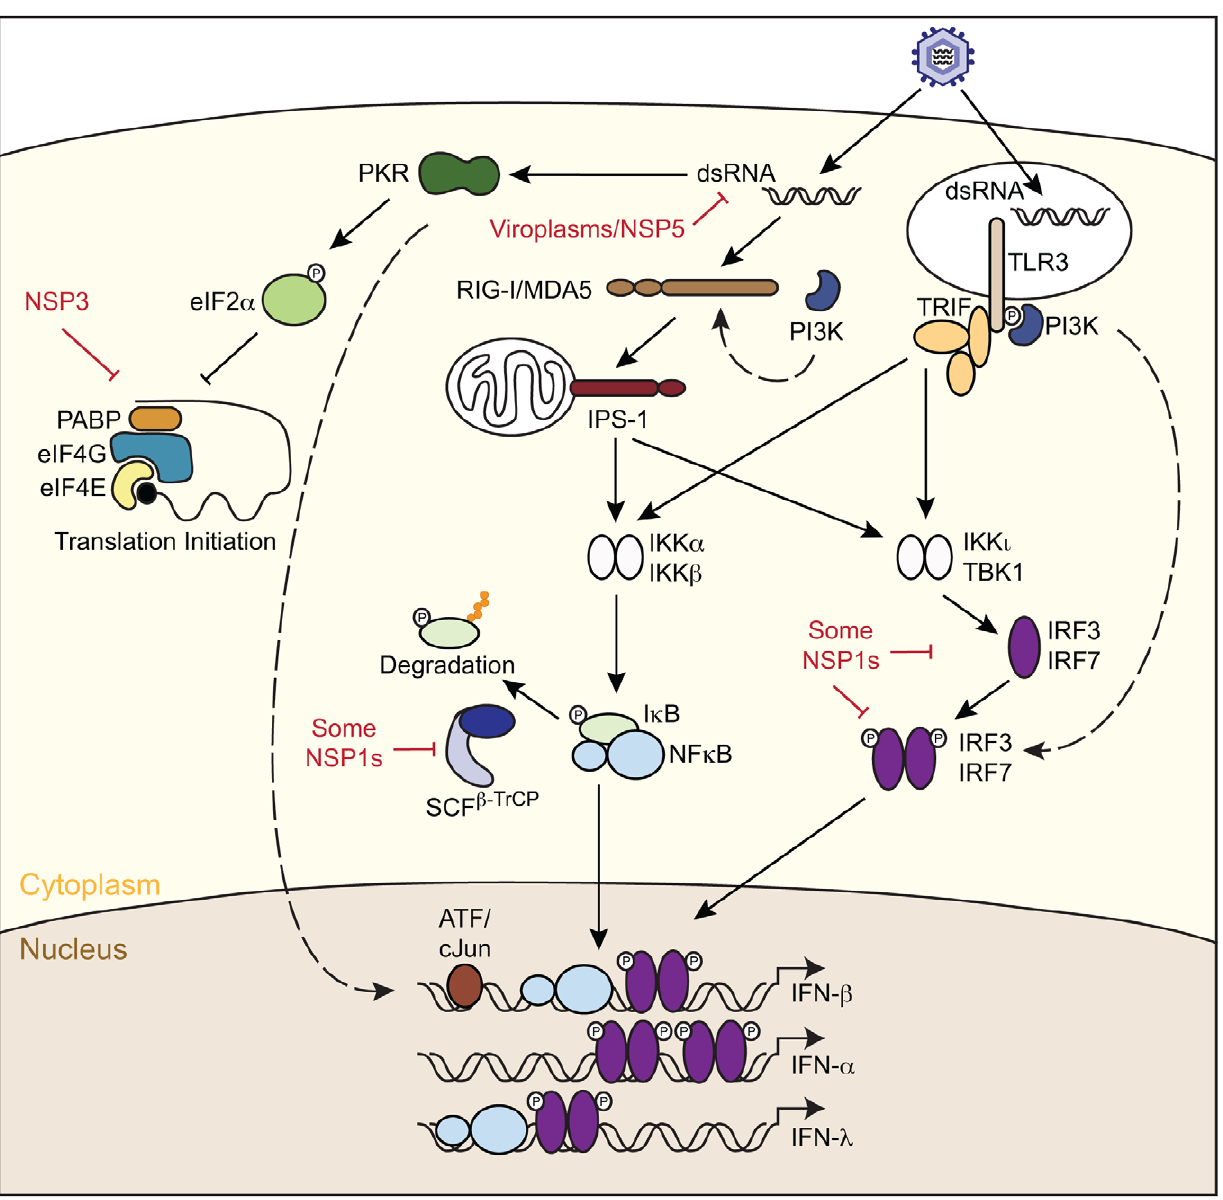
Figure 2. Rotavirus interactions with innate signaling pathways. Viral nucleic acids may be recognized in a host cell by membrane-bound Toll-like receptors (TLR3) or cytoplasmic RIG-I-like receptors (RLRs). When activated by nucleic-acid binding, RLRs recruit and activate the signaling adaptor molecule IPS-1, which recruits a signaling complex that activates latent cytoplasmic transcription factors such as interferon regulatory factor 3 (IRF3) and nuclear factor- k B (NF- k B). TLR3 activation stimulates the recruitment of the adaptor TRIF, which acts as a platform for a variety of signaling molecules that also phosphorylate IRF3 or NF- k B. When signaled, the C-terminus of IRF3 is phosphorylated, causing a conformational change that leads to dimerization and nuclear translocation. NF- k B is held inactive by inhibitor of NF- k B (I k B). Signals generated during viral infection cause phosphorylation of I k B, followed by ubiquitination (orange circles) and proteasomal degradation mediated by the SKP-CUL-F-box- b -TrCP (SCF b - TrCP ) E3 ubiquitin ligase complex. NF- k B subsequently translocates to the nucleus. IRF3 and NF- k B bind to the IFN- b promoter in a cooperative manner with c-Jun/ATF-2 forming an enhanceosome complex initiating the transcription of IFN- b mRNA. Additional transcription factors, including IRF7, are induced by IFN- b and can also bind to the IFN- b promoter to enhance the transcription of IFN- b and IFN- a genes. PI3K activity may be required for mediating TLR3 and RIG-I signaling by an unknown mechanism (dashed line). PKR responds to dsRNA binding by phosphorylating eIF2 a , which ultimately inhibits translation initiation. PKR is also thought to promote the secretion of IFN- b by an unknown mechanism (dashed line). Rotavirus can antagonize innate signaling pathways through several avenues (shown in red), the primary one representing the NSP1-induced degradation of IRF3 and IRF7. Some NSP1 proteins are also known to induce the degradation of b -TrCP. Rotavirus NSP3 can also impede antiviral responses by suppressing the translation of host mRNAs generated from IFN-stimulated genes. By sequestering viral RNAs within viroplasms, the virus can prevent their recognition by PKR, RIG-I, MDA-5, and other sensors that upregulate antiviral responses.